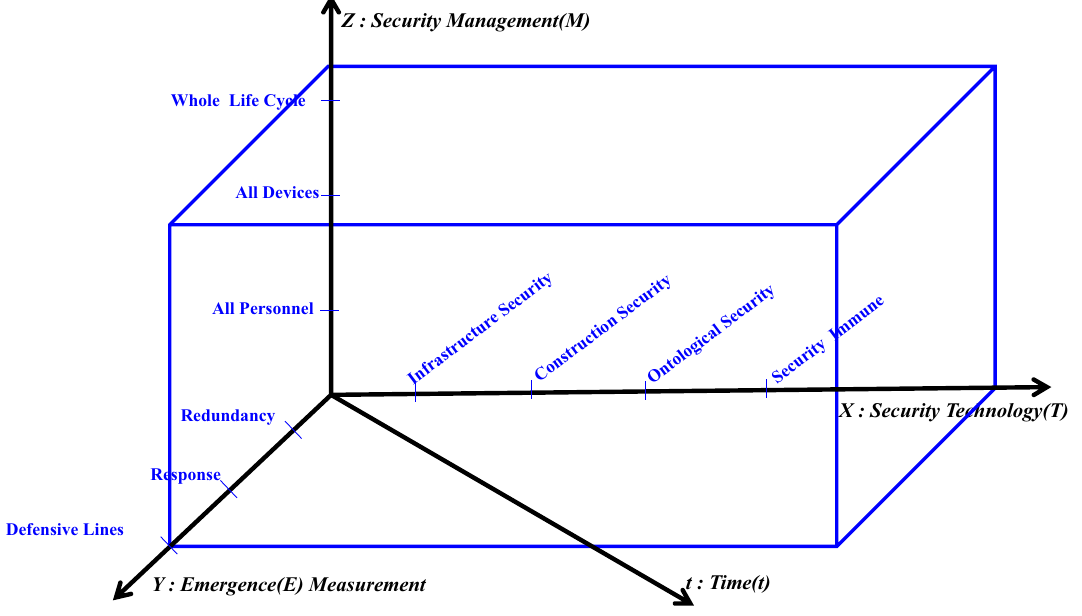
Figure 4. Protection architecture (TEMt) of endogenous safety and